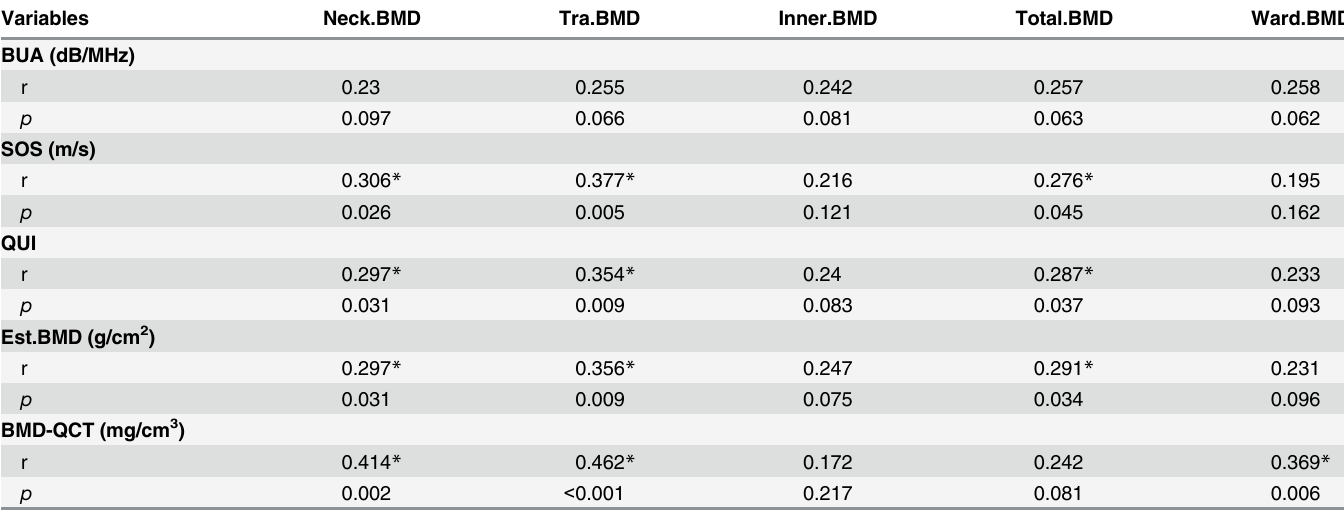
Table 2. Pearson ’ s correlation of the acoustic parameters with the BMD of the proximal femur